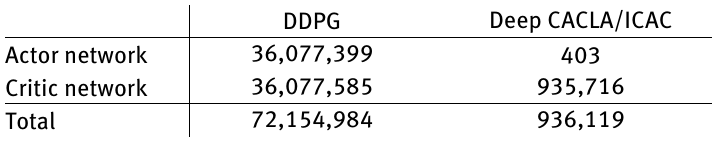
Table 1: Comparison between the number of learning parameters of the different deep architectures used in the